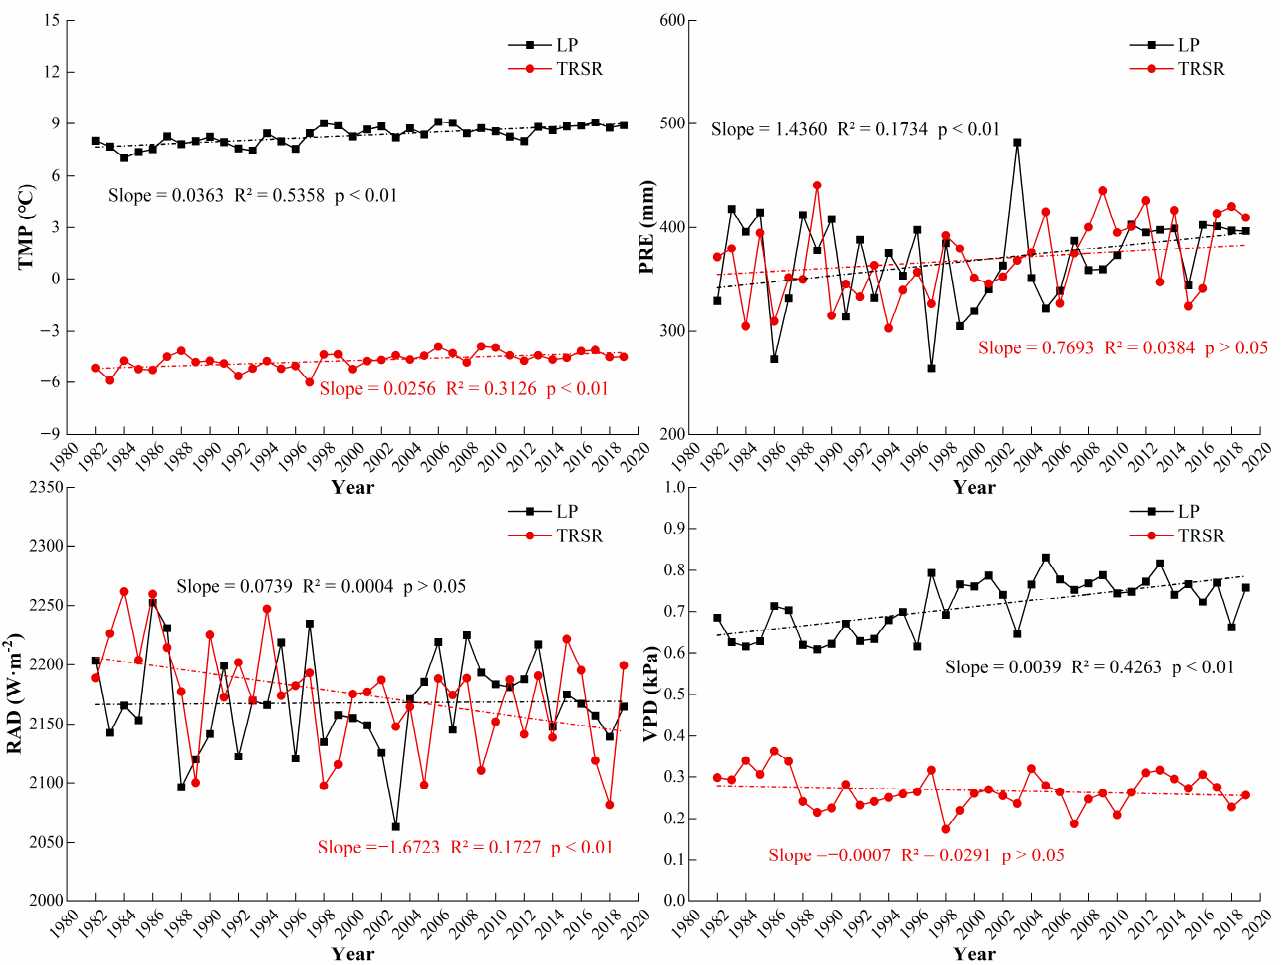
Figure 4. Interannual changes in annual mean climatic variables (TMP, PRE, RAD, and VPD) during 1982–2019. TMP, PRE, RAD, and VPD represent temperature, precipitation, downward surface shortwave radiation, and vapor pressure deficit, respectively.